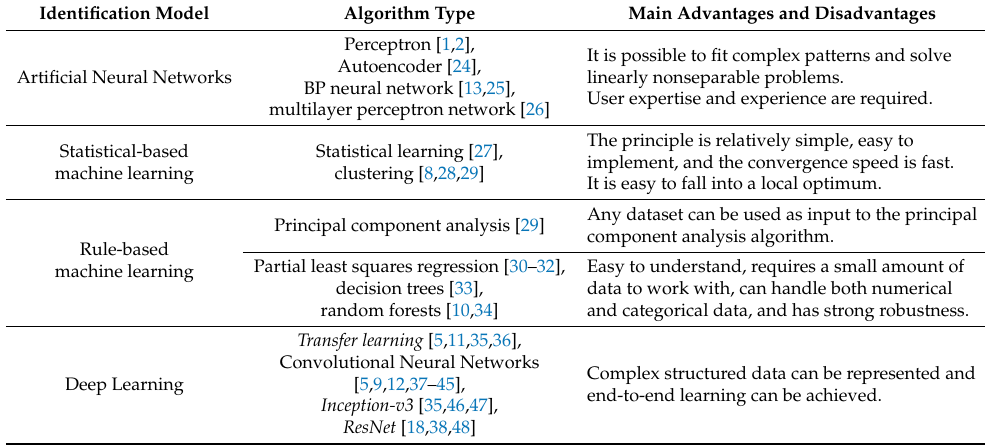
Table 1. Comparison of different machine learning methods for intelligent identification of